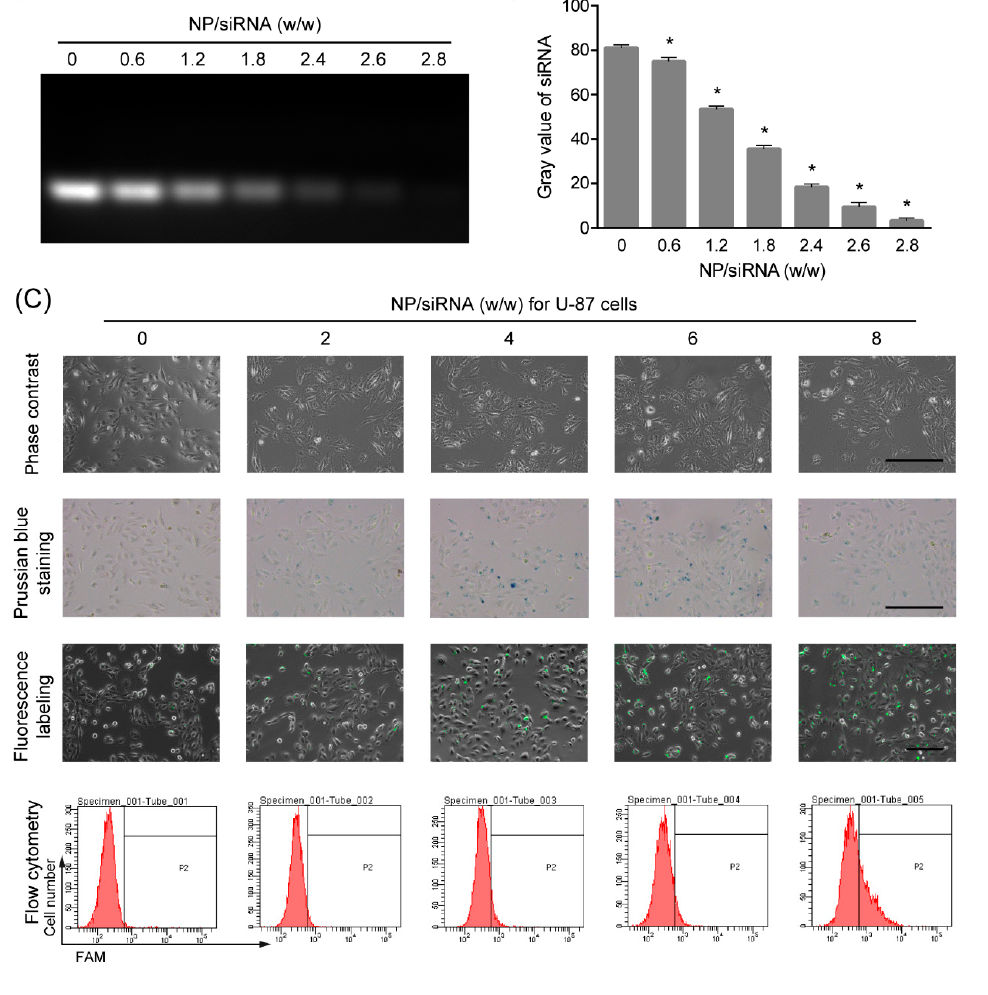
Figure 2. The cellular uptake of the NP/siRNA complexes in U-87 cells. ( A ) The interaction of the PEI-coated Fe 3 O 4 NPs with siRNA at different NP/siRNA weight ratios, analyzed by gel retardation assay; ( B ) the gray value analysis for the results of gel retardation assay. * p < 0.05 compared with the 0 group; ( C ) the cellular uptake of the NP/siRNA complexes in U-87 cells was verified by prussian blue staining, fluorescence labeling and flow cytometry, P2 presented positive proportions. Bar indicates 100 μ m.